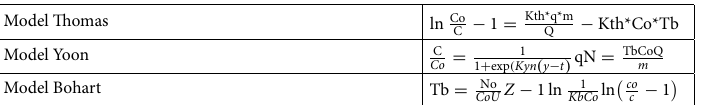
Table 1. Models of the adsorptions. Where Co Initial concentration of Cr (VI), C Final Cr (VI), V volume, KTh Thomas constant (ml/mg*min), q Adsorption capacity (mg Cr /g biomass), m Mass of biomass in column (g), Q Flow rate through the column (ml/min), Tb Time of rupture (min), K YN constant Yoon y Nelson (1/h), q γ Capacity (mg/g), Z bed height (cm), U is the linear flow rate (cm/min1), Kb Bohart constant